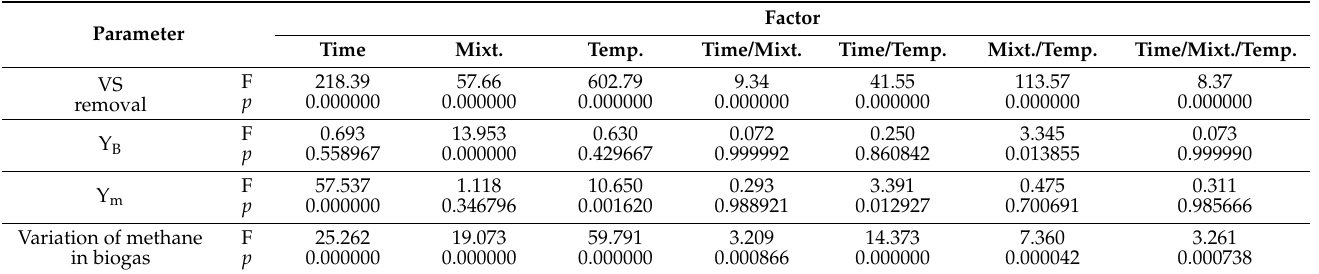
Table 5. Results related to the factorial ANOVA analysis ( α = 0.05) with three